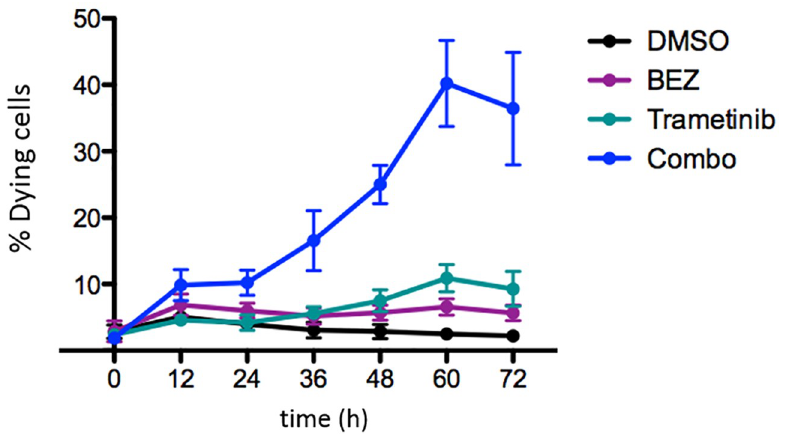
Fig 6. Death time series data for model training. The YO-PRO-1 dye was used to quantify the proportion of dying cells every 12h in response to drug treatment [18]. The cells were treated with DMSO (baseline), 1 μ M Trametinib, 1 μ M BEZ235, or the combination of 1 μ M Trametinib + 1 μ M